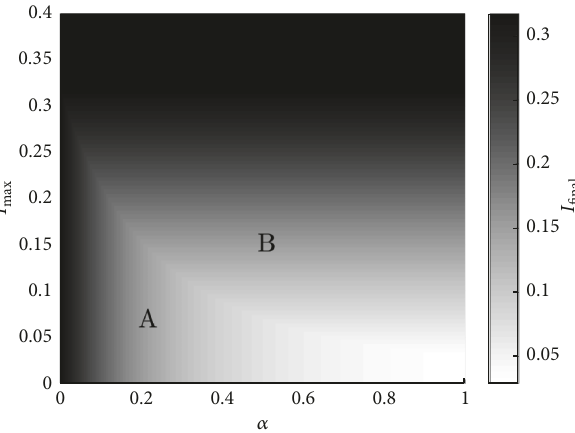
Figure 9: Influence of 𝐼 max and 𝛼 on 𝐼 proportions of infected nodes in all nodes. Moreover, 𝐼 average of 100 values for 𝑡 > 10000 . Here all other parameters are the same as Figure